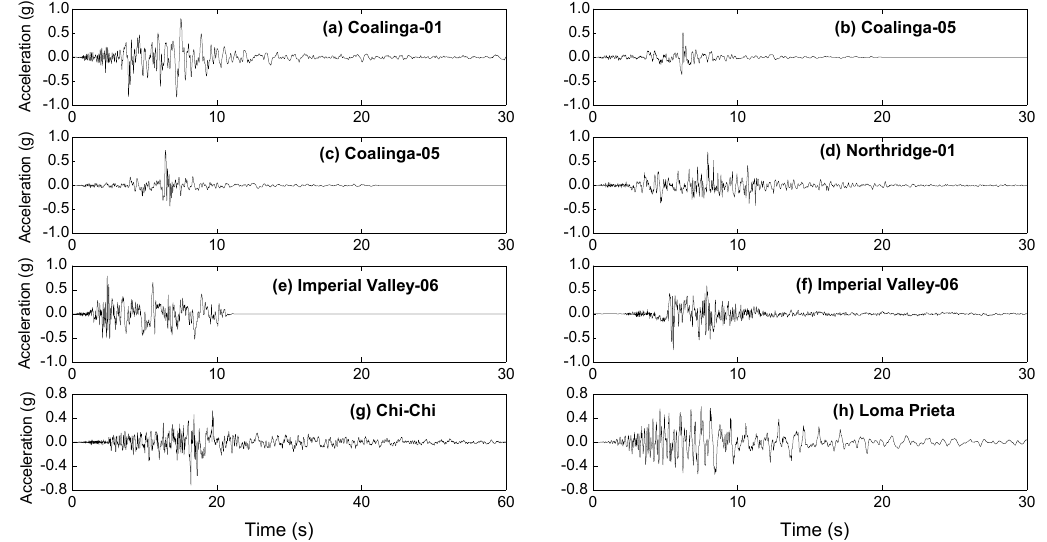
Figure 13. Eight time history recommendations for Pingtung (site e) with DSHA calculations and the NGA strong-motion database.